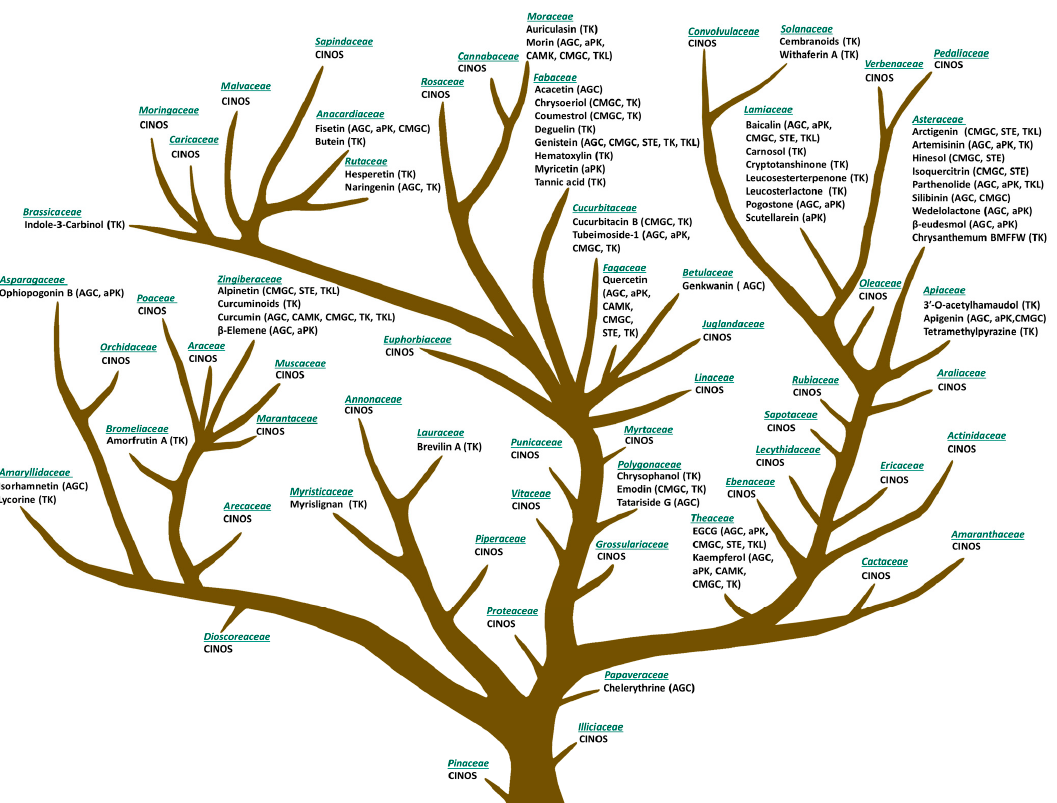
Figure 3. Evolutionary Tree of Plant-Derived Small Molecule Inhibitors. Adapted from [47,48] and supplemented with natural products with protein kinase-inhibiting properties using information from the literature [38,43,45,49–60]. Phytochemicals indicate only the botanical families where they were first discovered from. Other families still contain compounds identified but are not an original source (CINOS). More information is available in Supplementary Table S4.